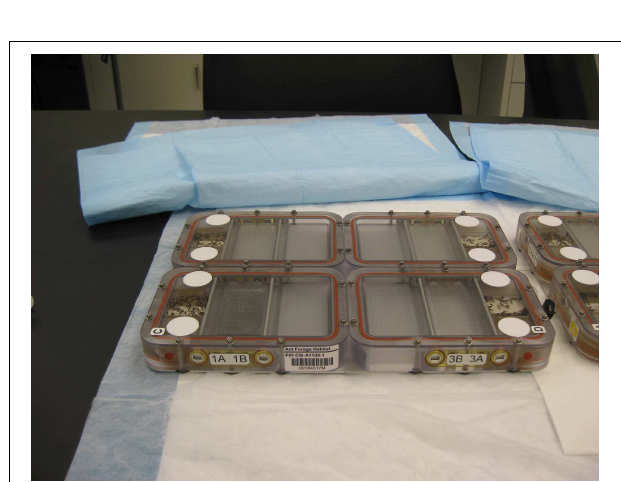
FIGURE 2 | Arenas right before loading on Cygnus capsule to travel to the space station.